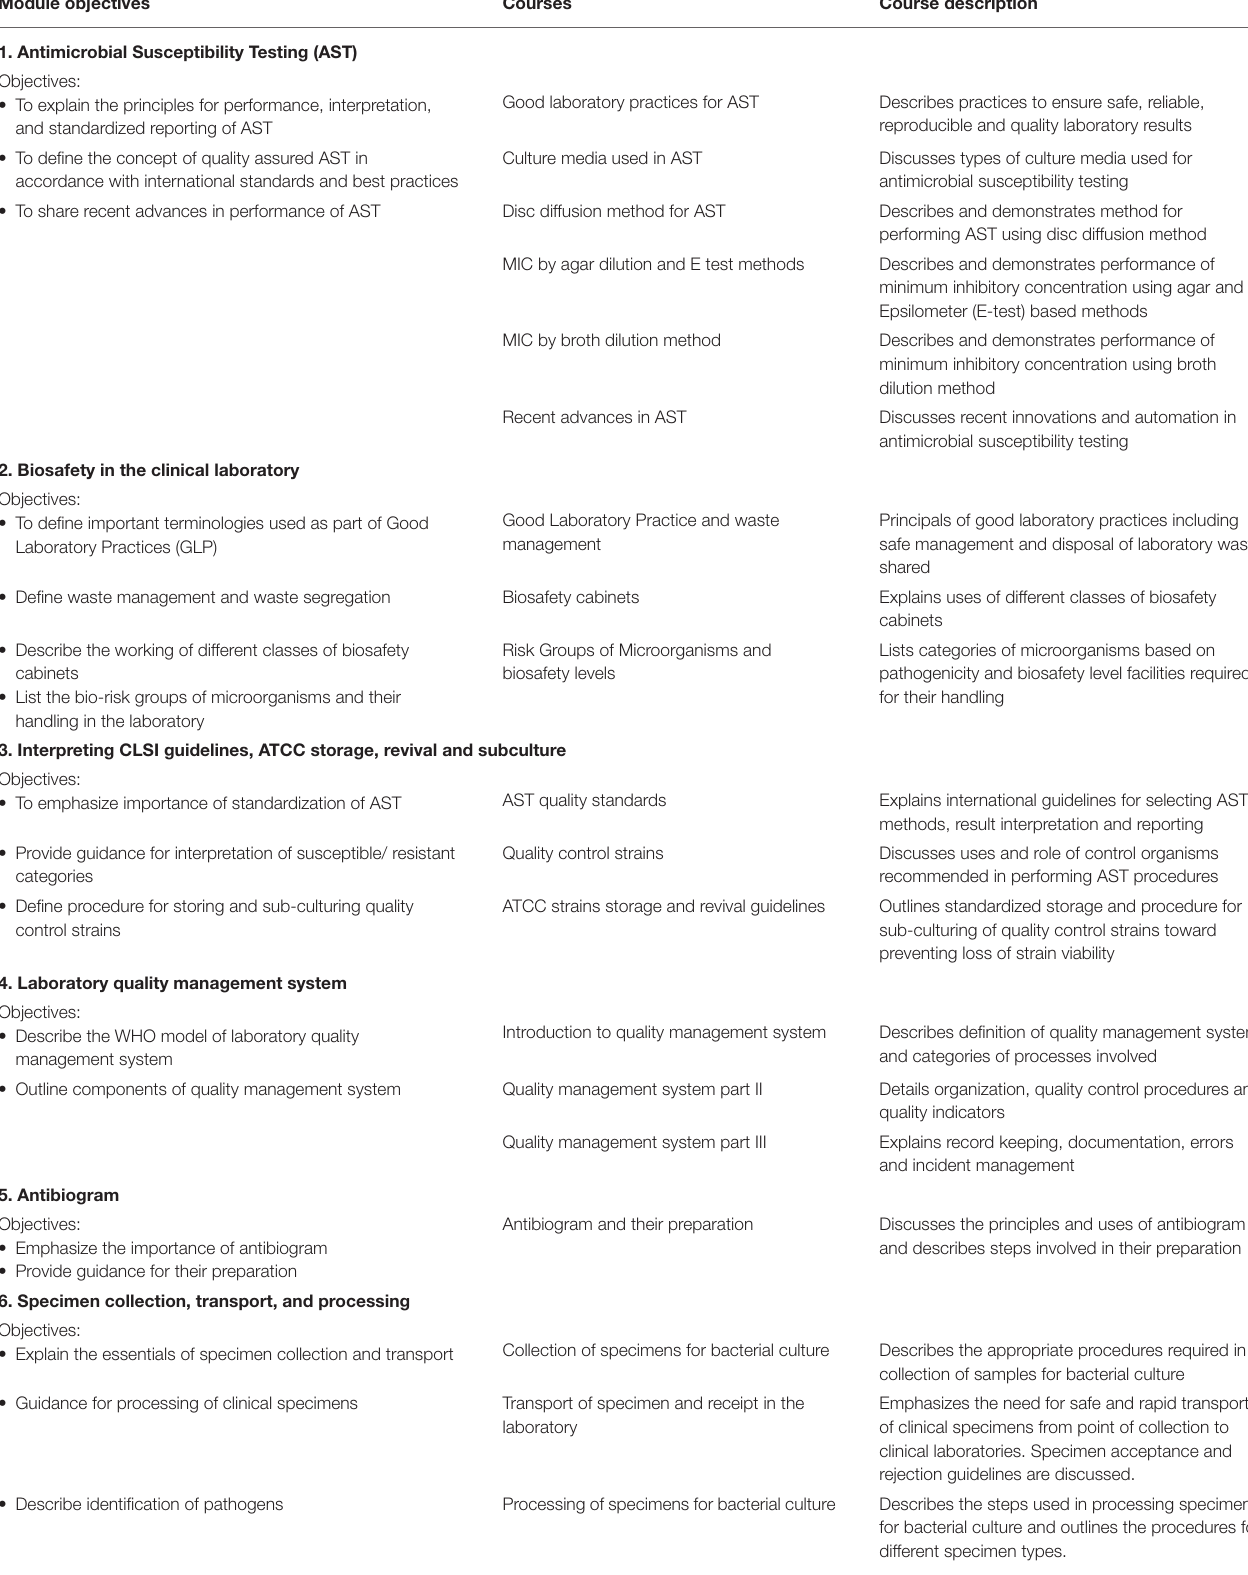
TABLE 1 | List of modules and the courses offered. Module